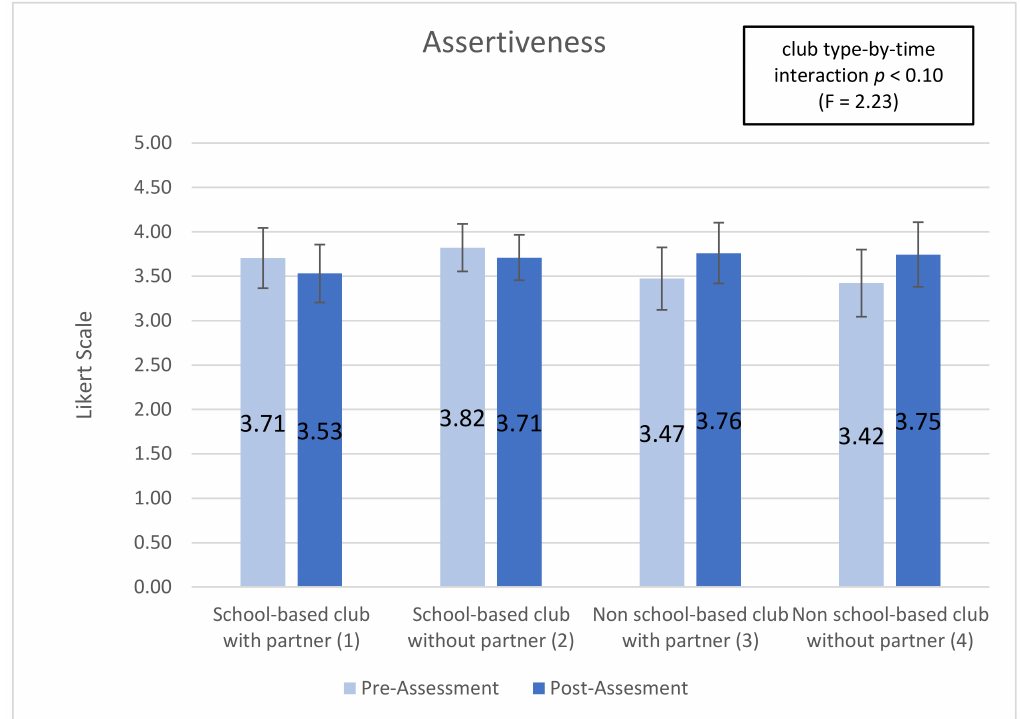
Figure 2. Assertiveness pre- post-assessments by club type and